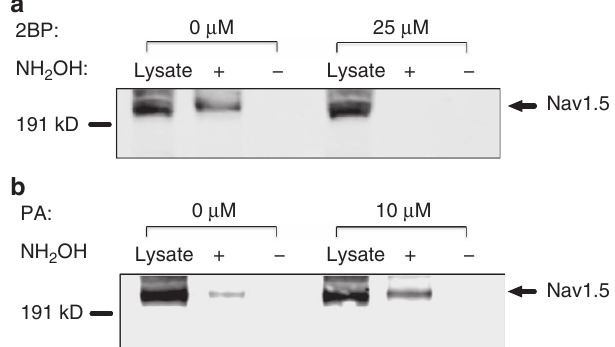
Figure 3 | Palmitate lipid treatments alter Nav1.5 palmitoylation in HEK293 cells that stably express Nav1.5. The results are representative of at least three independent experiments. ( a ) 2-Br-palmitate(2BP) treatment inhibited Nav1.5 palmitoylation at 25 m M. ( b ) Palmitic acid(PA) treatment increased Nav1.5 palmitoylation at 10 m